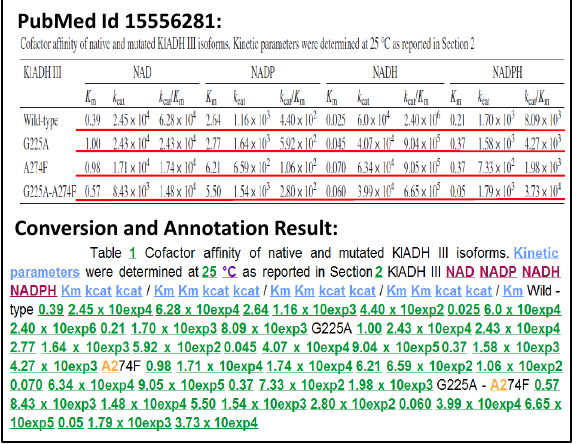
Figure 11: Comparison between original PDF and converted/annotated result showing a successful